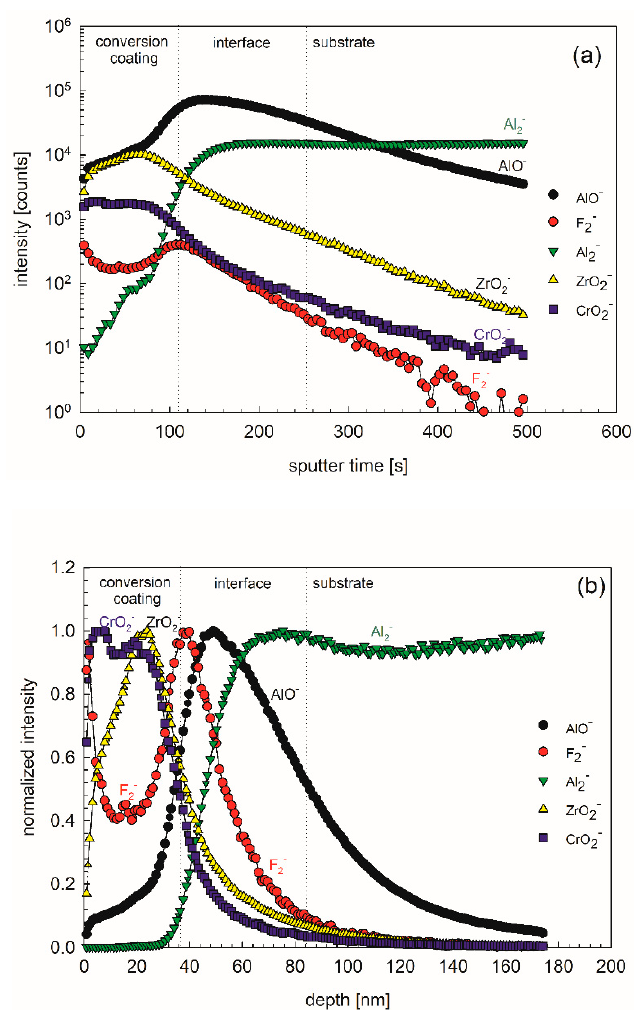
Figure 18. ToF-SIMS depth profiles (negative ions) recorded on the chemically pre-treated AA3003 sample coated using conversion coating ST650 prepared at 10% concentration and conversion time of 18 min at room temperature. Three regions are indicated, denoting conversion coating, interface layer and substrate. ( a ) presents intensity vs. sputter time and ( b ) normalized intensity vs. depth (sputter rate 0.5 nm / s relative to a Ni / Cr standard).